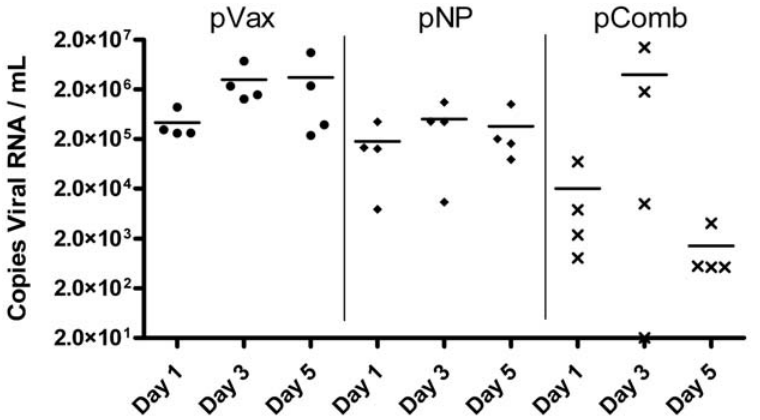
Figure 5. Viral shedding following challenge with HPAI. Nasal washes were collected every other day immediately following challenge. RT- PCR was performed to determine the RNA copy number from each group.